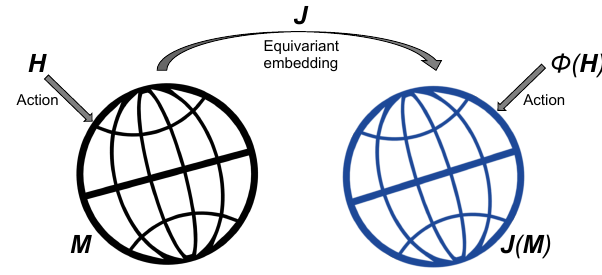
Figure 1. A simple illustration of equivariant embeddings. Algorithm 1 Extrinsic Bayesian optimization on